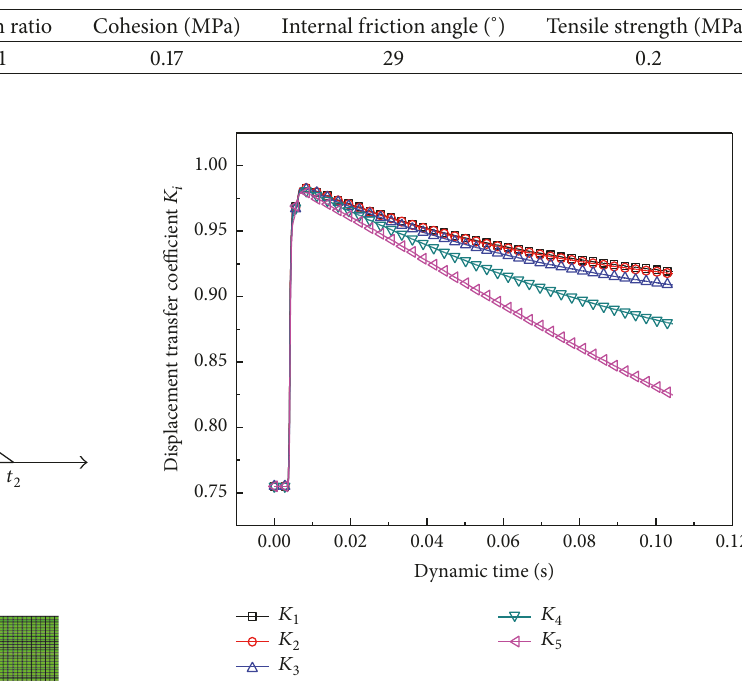
Figure 11: Curves of the displacement transfer coefficient with